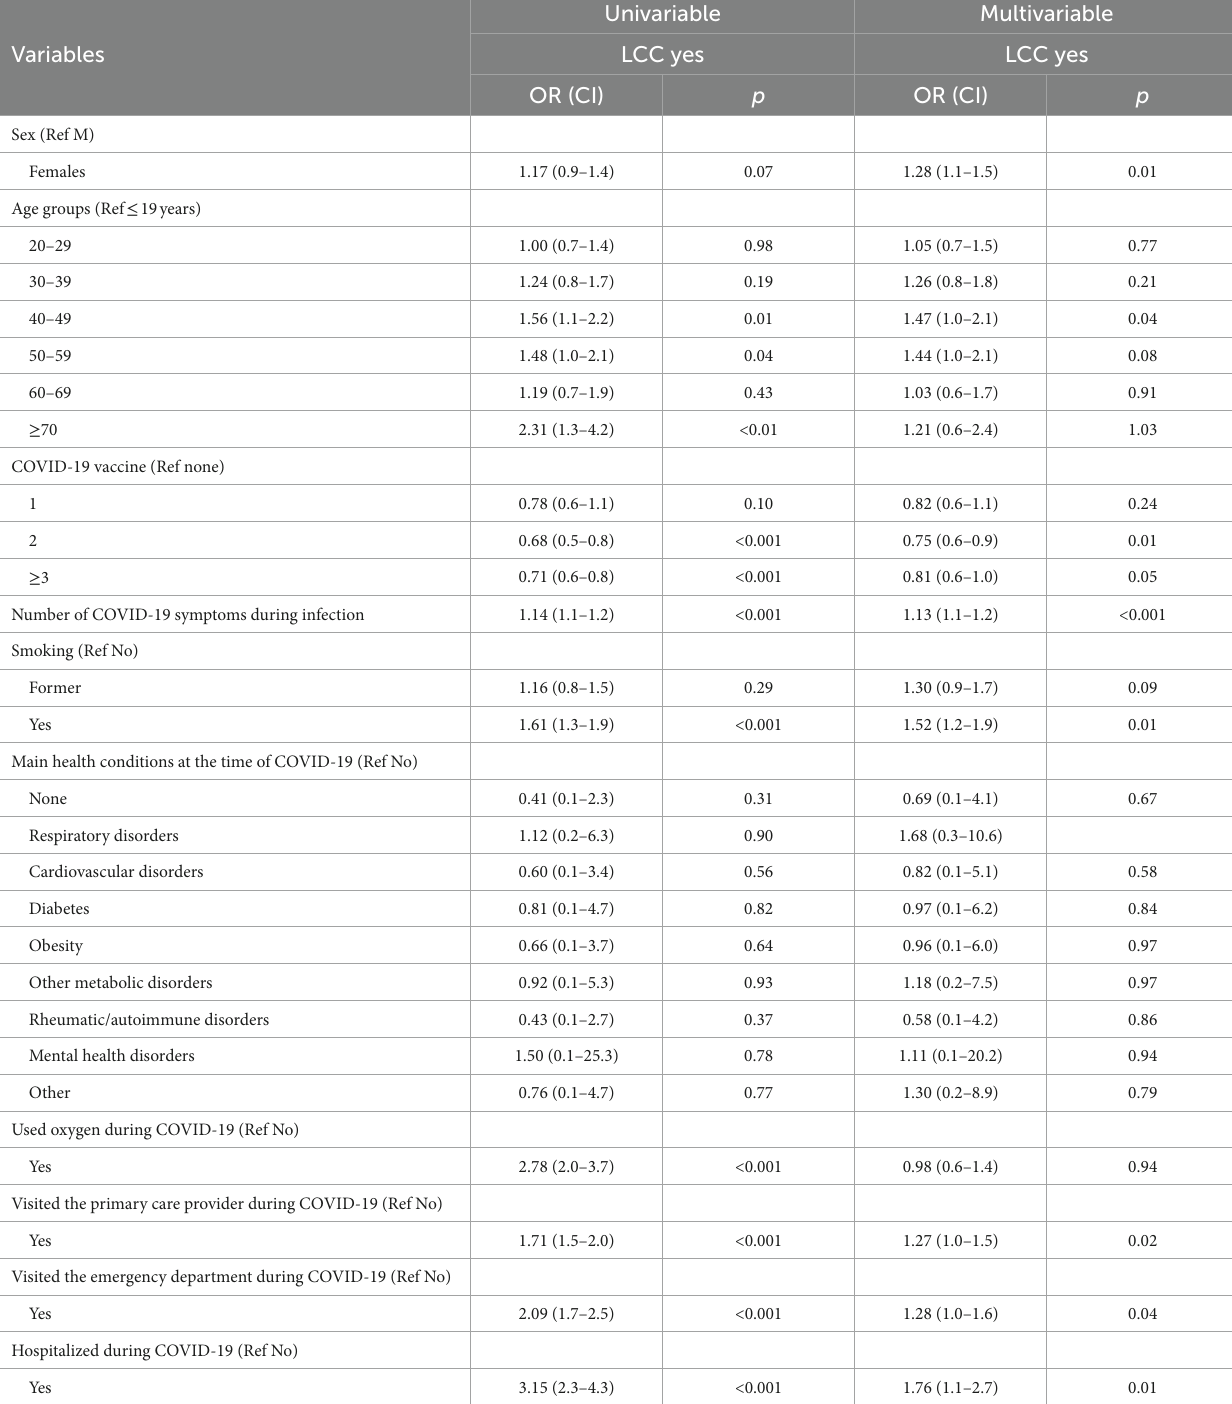
TABLE 2 Factors associated with reported long COVID